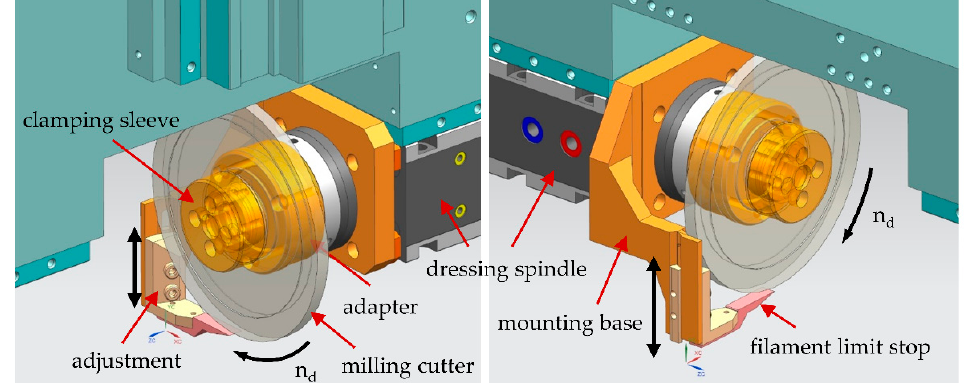
Figure 15. Front and rear views of the CAD model of the conditioning device.